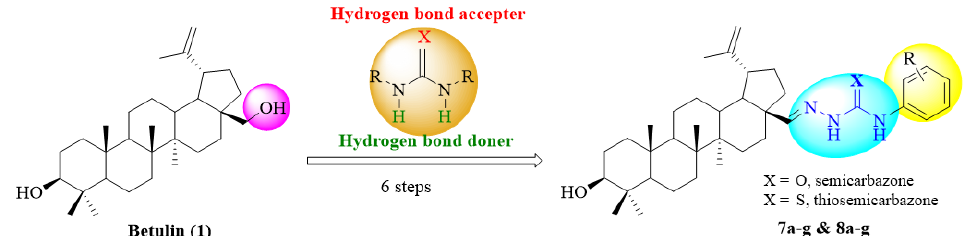
Figure 3. Design strategy of novel betulin derivatives.